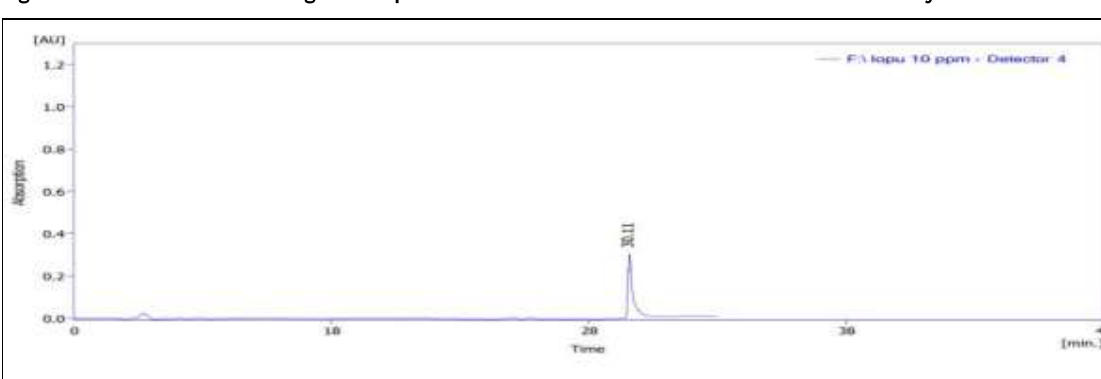
Figure 12. PHPLC chromatogram of petroleum ether fraction of stems that extracted by hot method.